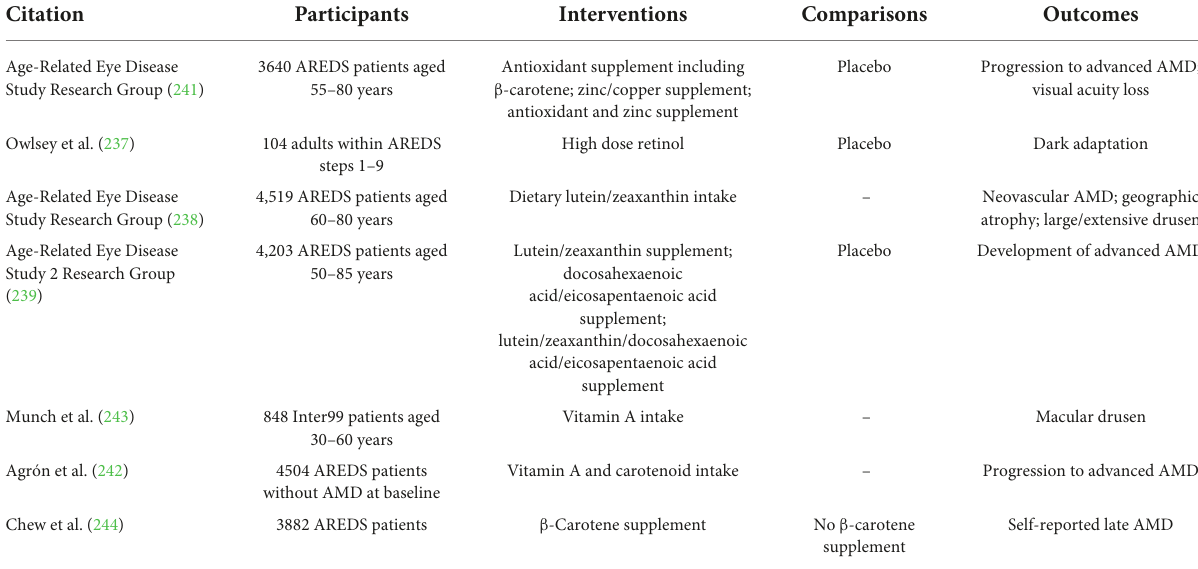
TABLE 4 Human-based studies relating to vitamin A in AMD, with PICO characteristics summarised.